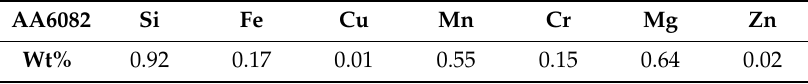
Table 1. Chemical composition of the extruded profile of